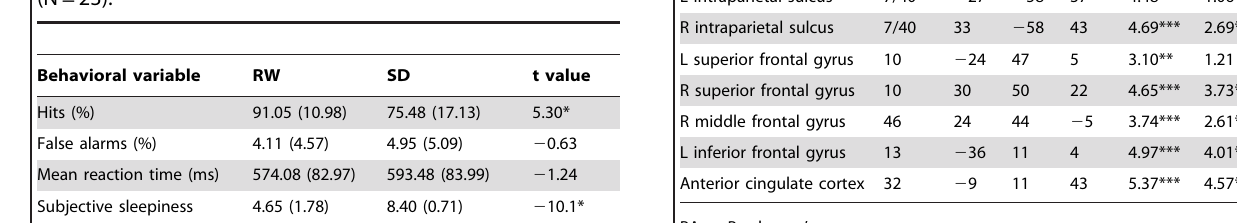
Table 1. Behavioral data from the selective attention task (N= 23).